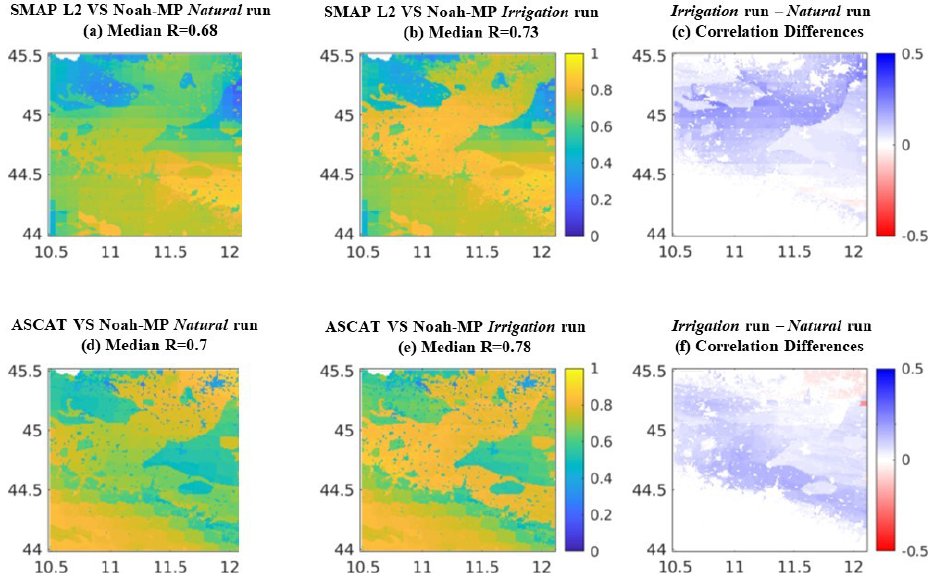
Figure 4. Maps of temporal Pearson R between biweekly values of SSM from Noah-MP and satellite retrievals. (a) Natural run and SMAP L2. (b) Irrigation run and SMAP L2. (d) Natural run and ASCAT. (e) Irrigation run and ASCAT. Maps of the Pearson R differences display the grid-based difference between (c) map b and map a and (f) map e and map d . The reference period is April 2015–December 2019.